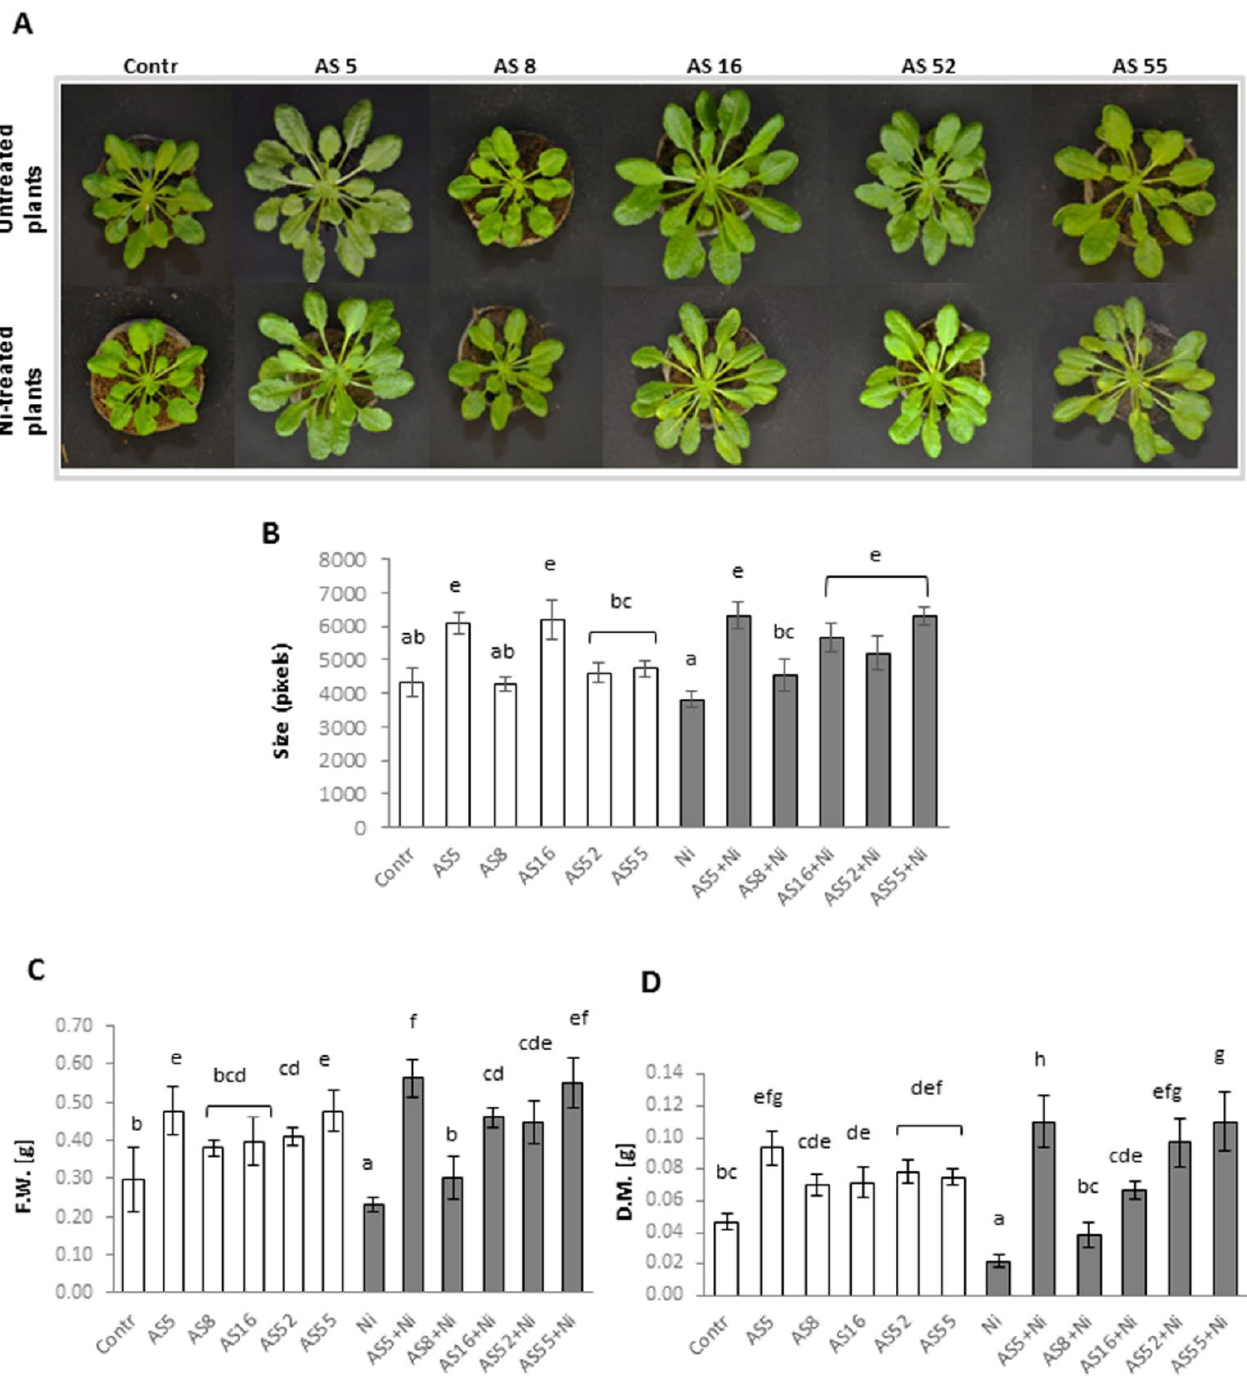
Figure 2. Arabidopsis growth non-exposed (white bars) and exposed to 200 µM Ni (grey bars) for 4 weeks, in the absence or presence of rhizobia strains. ( A ) Pictures of plants cultivated under laboratory non-stress conditions (top row) and exposed to Ni (bottom row), ( B ) rosettes size, ( C ) fresh weigh (FW), and ( D ) dry mass (DM) of Arabidopsis plants. Values are mean ± SD. The same letters indicate the homogenous groups according to the Tukey HSD test at the level p = 0.05.